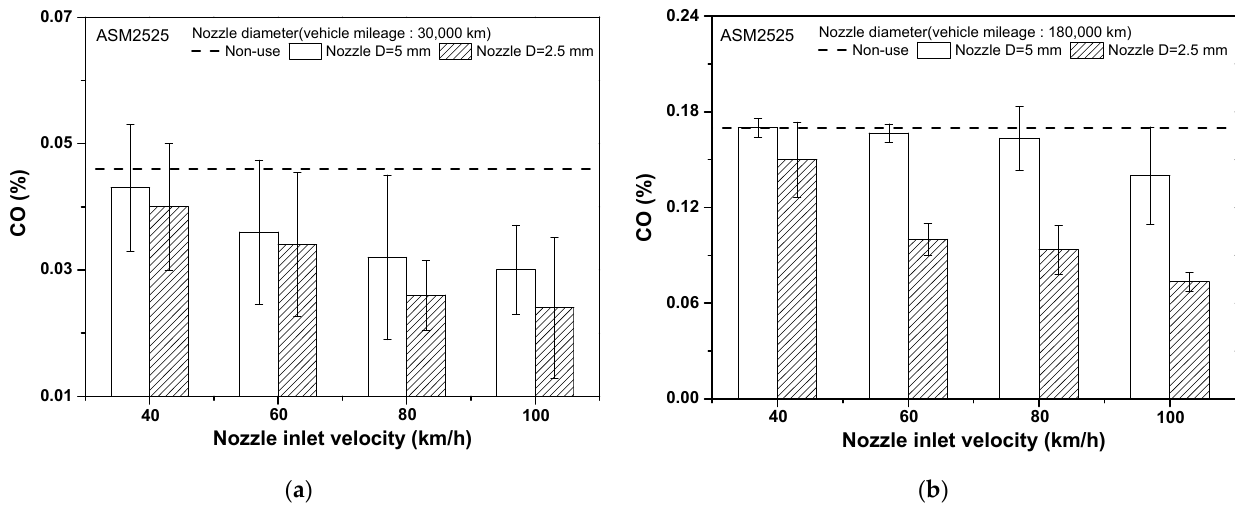
Figure 9. Variation in CO according to nozzle diameter for 30,000 and 180,000 km mileage engines: ( a ) 30,000 km engine; ( b ) 180,000 km engine.